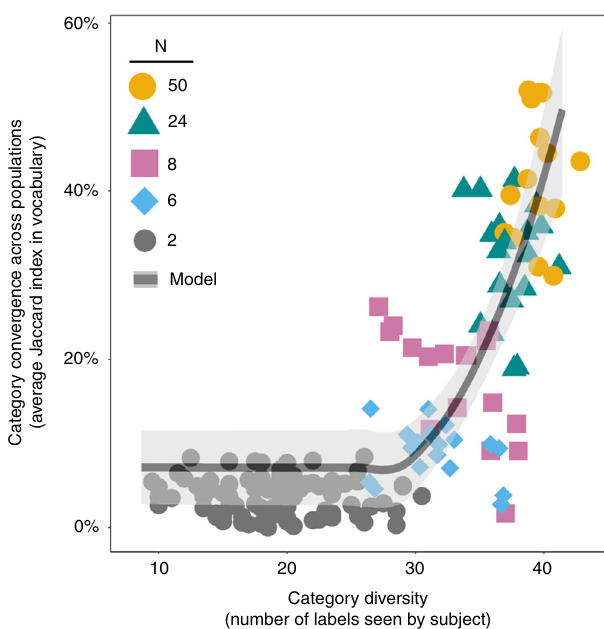
Fig. 2 Convergence in the vocabularies that emerged in populations of different sizes, for N = 2 (black dots), N = 6 (blue diamonds), N = 8 (purple squares), N = 24 (green triangles), and N = 50 (yellow circles). Vertical axis reports the average similarity in vocabulary (average Jaccard Index) between each network trial and all other networks of the same population size. Horizontal axis displays category diversity, measured as the average number of unique labels encountered by subjects in a population. Data points represent experimental results (80 dyads and 15 social networks of each size). Black trend line shows model predictions (averaged over 50 simulated trials; 100 rounds each trial; d min = 0.01; | L | = 5000; b = 1); see Supplementary Information section 1.2 for model speci fi cation (equation S1). The measure of center indicated by the model trend line is the mean Jaccard Index among simulated trials of the same population size, ordered by the average category diversity in each trial (Fig. S1). Error bands show 95% con fi dence